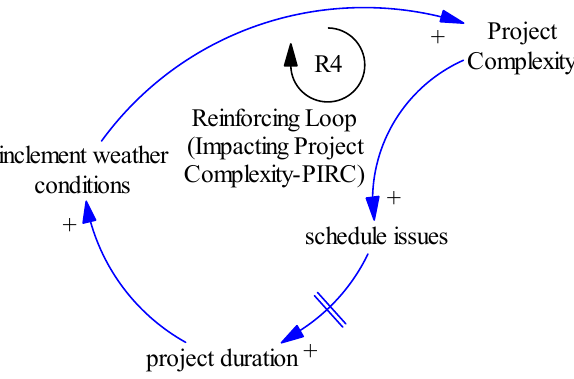
Figure 6. Impact on profitability risk category–complexity (reinforcing loop-R4).